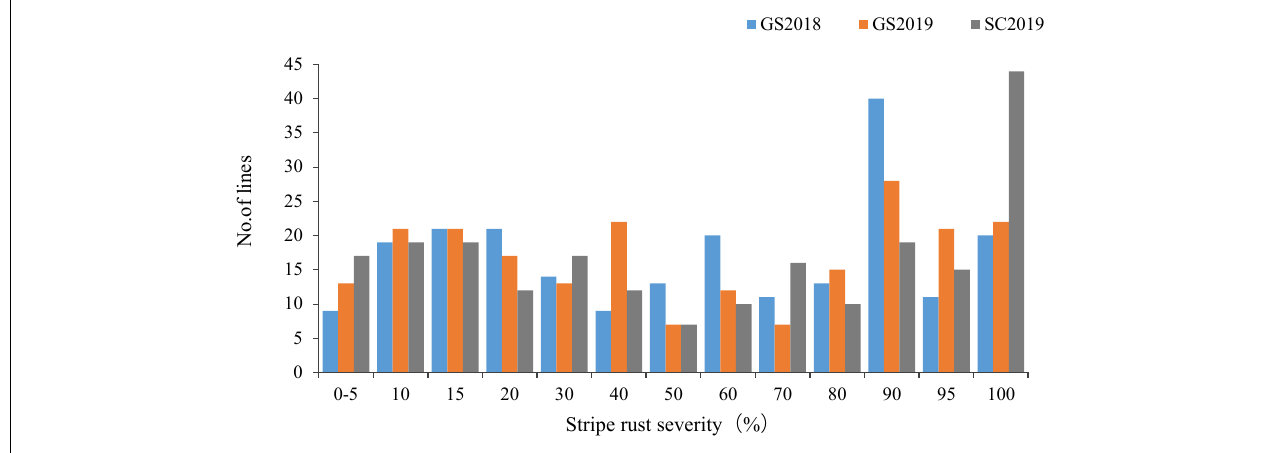
FIGURE 2 | Frequency distributions of 220 Huixianhong/Pascal F 5 recombinant inbred lines (RILs) for final disease severity of stripe rust in field traits at Gansu Province during 2017–2018 (GS2018), 2018–2019 (GS2019), and at Sichuan Province during 2018–2019 (SC2019).